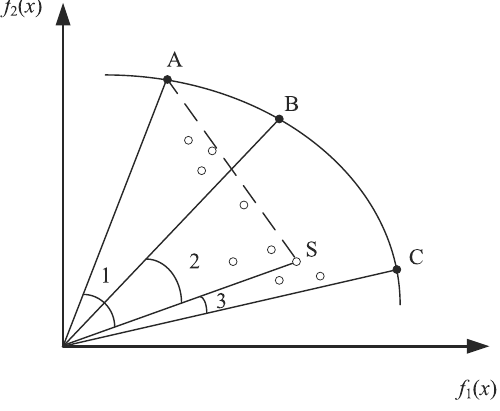
Fig. 8 Leader solution competitive selection mechanism for non-elite solution with large